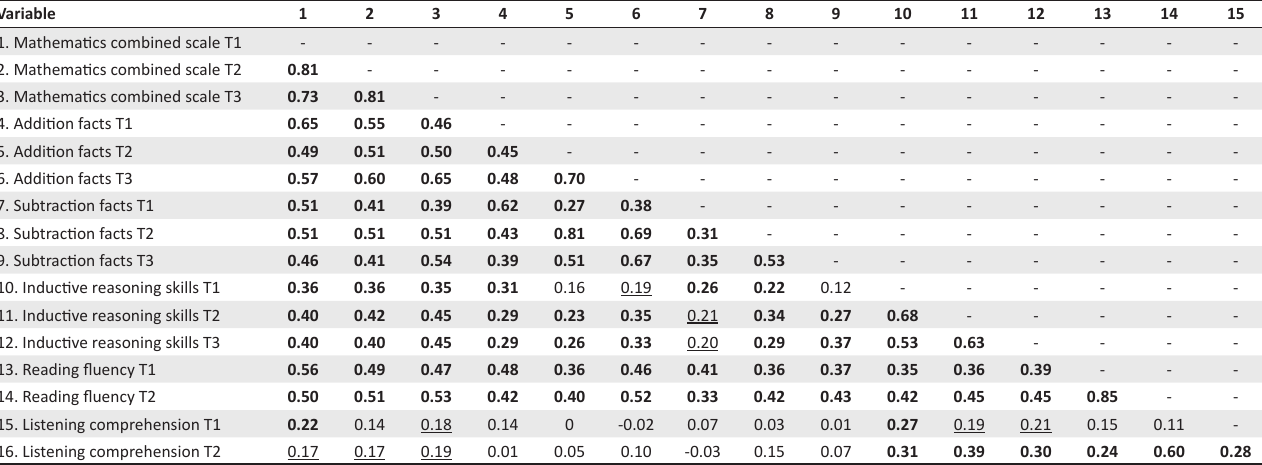
TABLE 3: Intercorrelation matrix of mathematics, inductive reasoning and language skills at assessment Times 1, 2 and 3. Variable